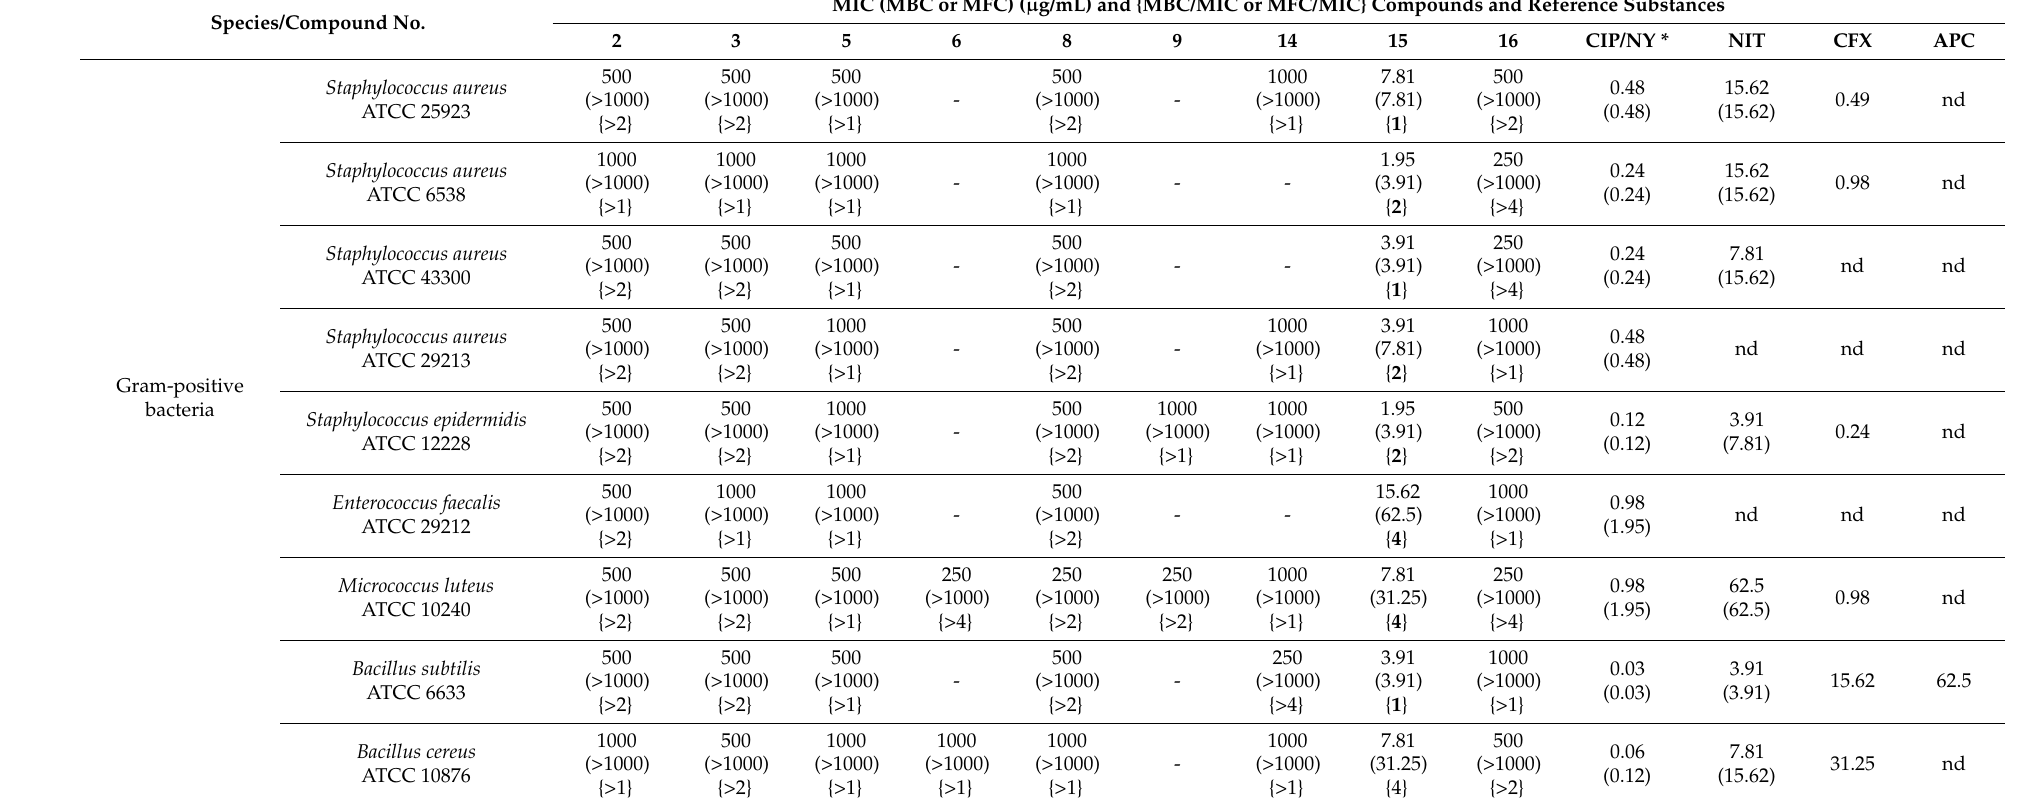
Table 1. The antimicrobial activity assay results for compounds 2 – 16 .